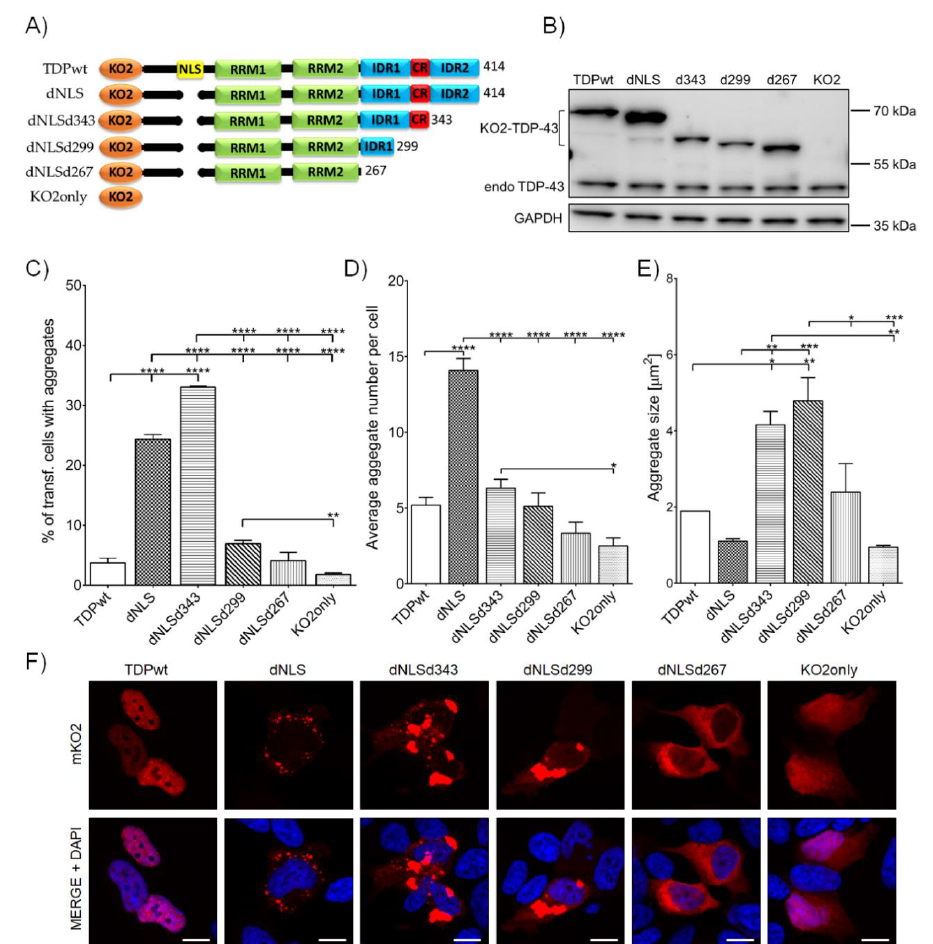
Figure 1. C -terminal domain truncations affect TDP-43 aggregate formation in the cytoplasm of SH-